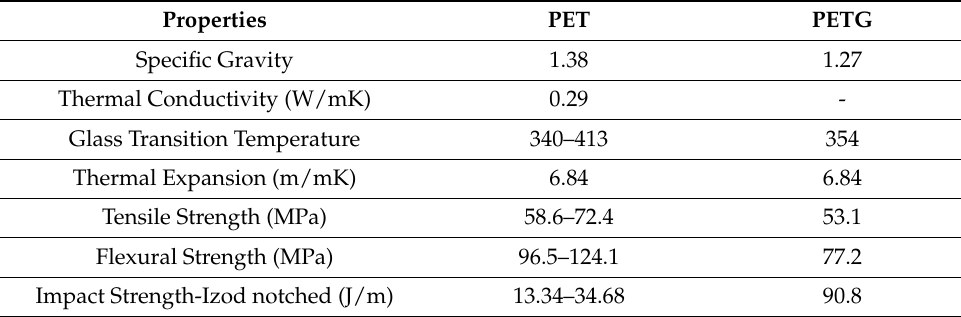
Table 3. Properties of PET and PETG